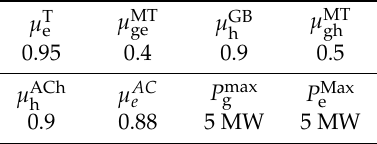
Table 2. Parameters for MT, EHe, GB, ACh, and Transformer Devices.